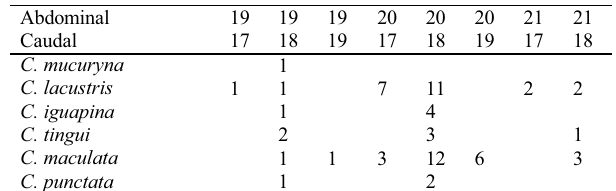
Table 8. Vertebrae count frequencies in species of Crenicichla from southeastern